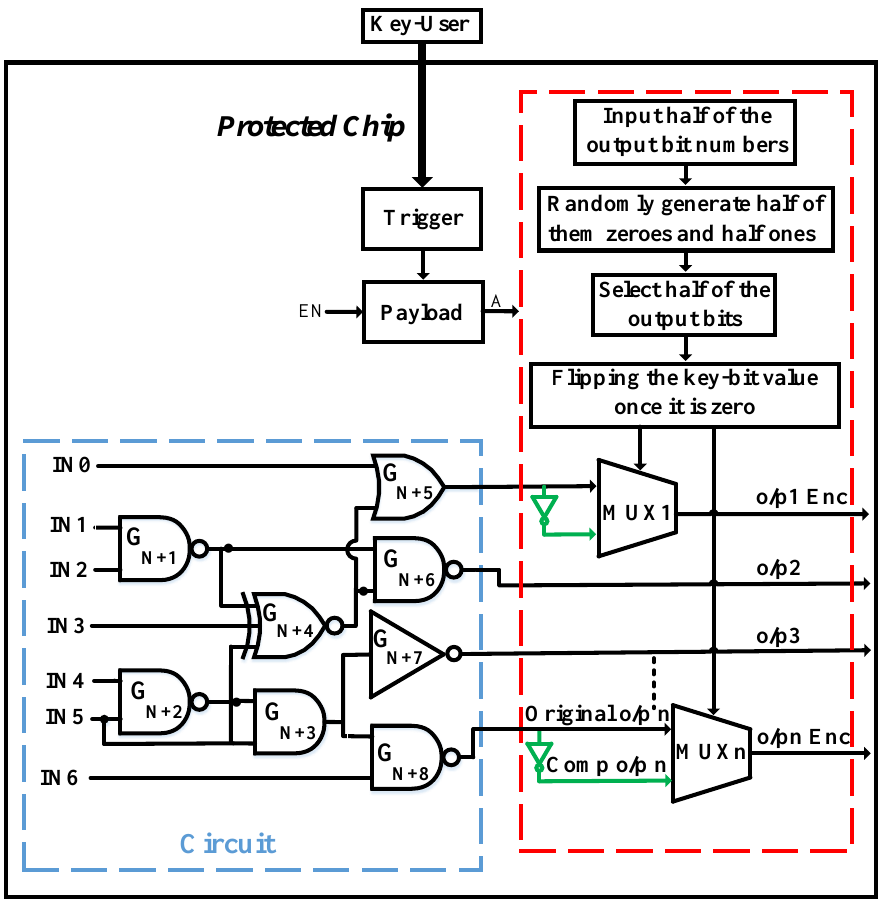
Figure 4. Logic encryption based on half multiplexer (MUX) insertions. o/p, Comp, n and Enc are the output, the complementary, the number of the output bits and encryption,